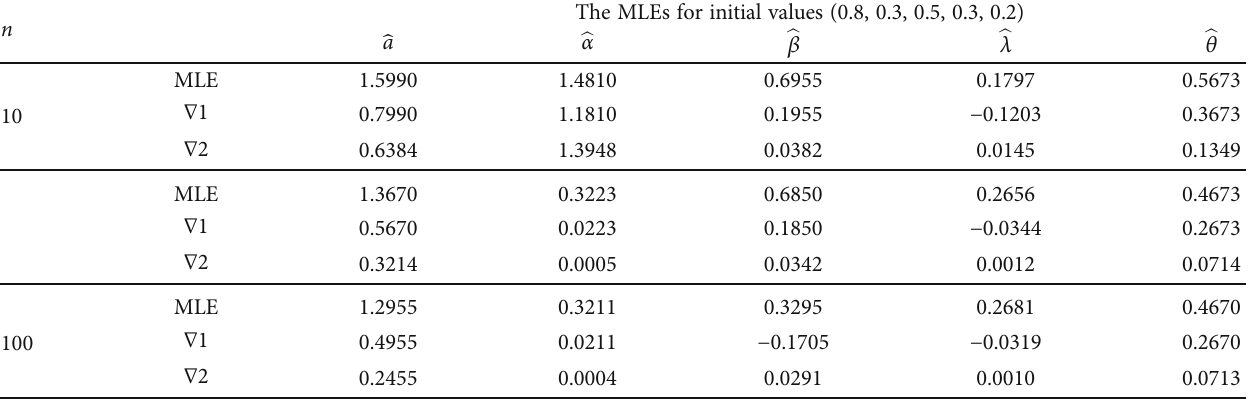
Table 2: The values of MLE, ∇ 1 and ∇ 2 for the unknown parameters a , α , β , λ , and θ at (0.8, 0.3, 0.5, 0.3, and 0.2), respectively. n